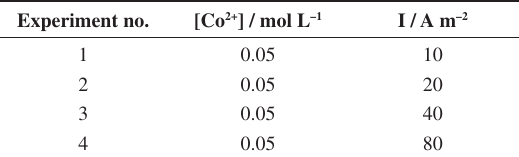
Table 2. Experimental conditions to produce Zn-Co coatings from citrate bath. Experiment